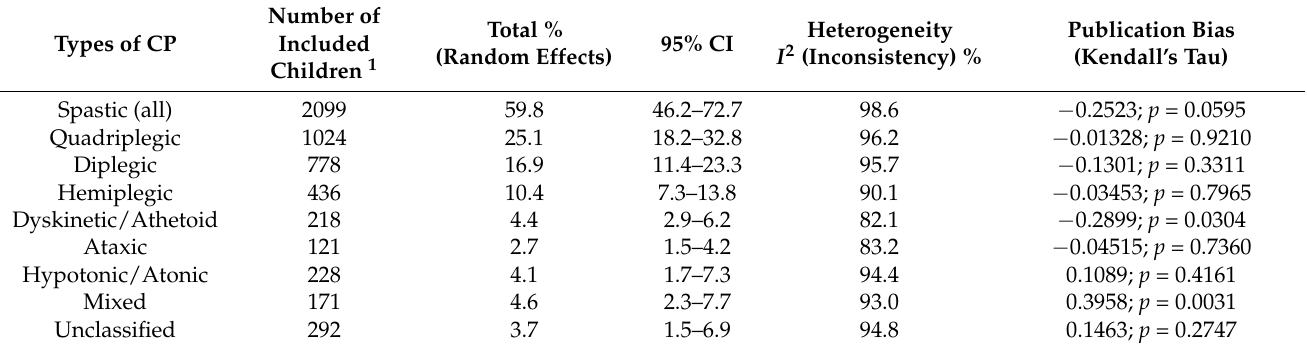
Table 3. Meta-analysis of CP types among children and adolescents in ASCs.